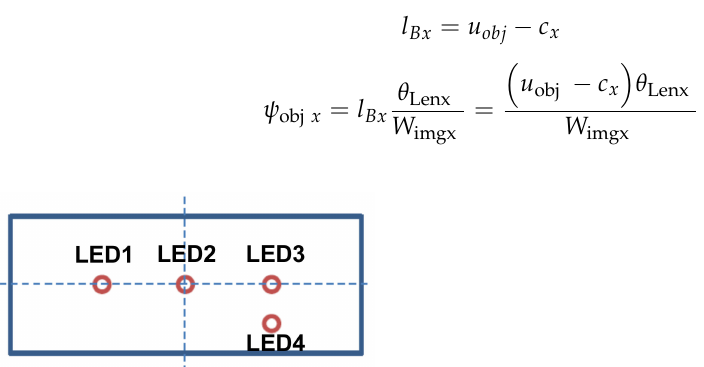
Figure 4. Arrangement of the LED light array on the